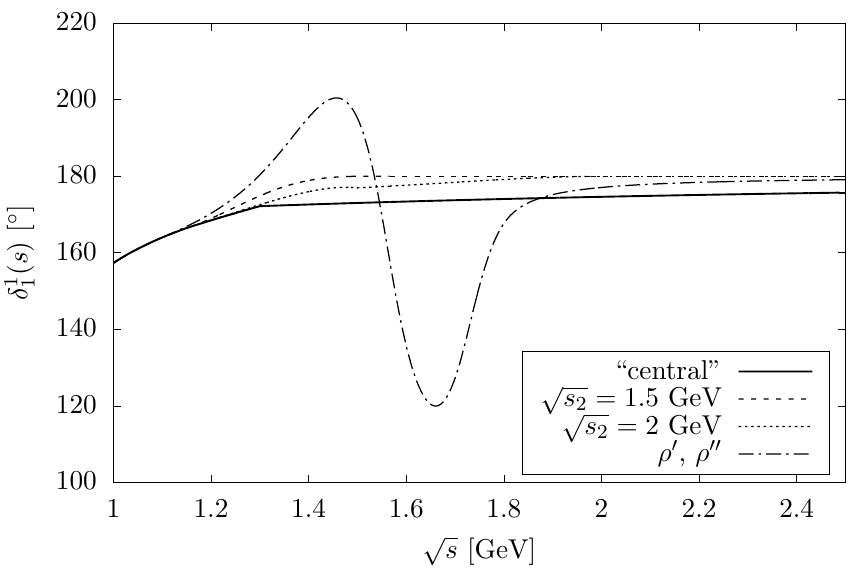
Figure 4. Continuation of the elastic P -wave (cid:25)(cid:25) scattering phase shift (cid:14) 1 validity of the Roy equations [10], used to estimate the impact of uncertainties due to the phase above 1 : 3